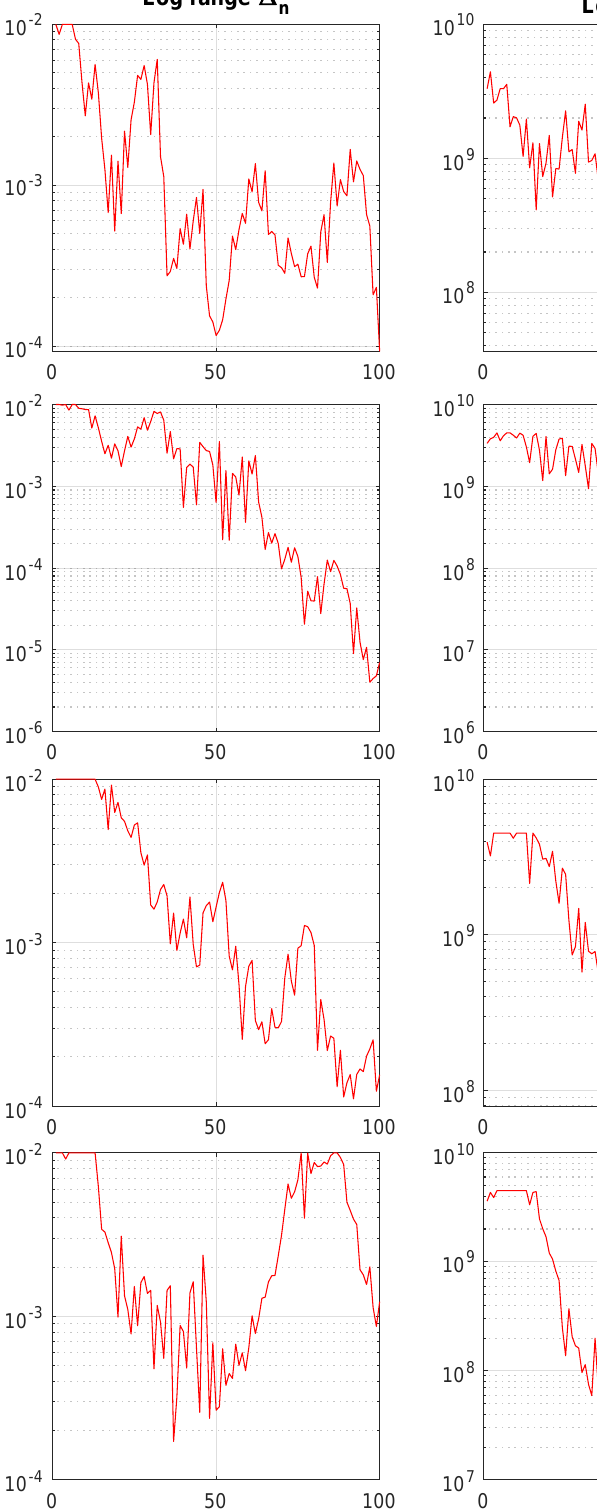
Figure A3. The three columns represent the evolution of each optimization variable ranges, respectively: ∆ n , µ and G . The horizontal axes are the PSO iterations and the vertical axes are in the units of the corresponding variable, Pa or adimensional for δ n . Swarm Population from top to bottom: 8–16–24–32. Objective function f ( x ) resolution: 8